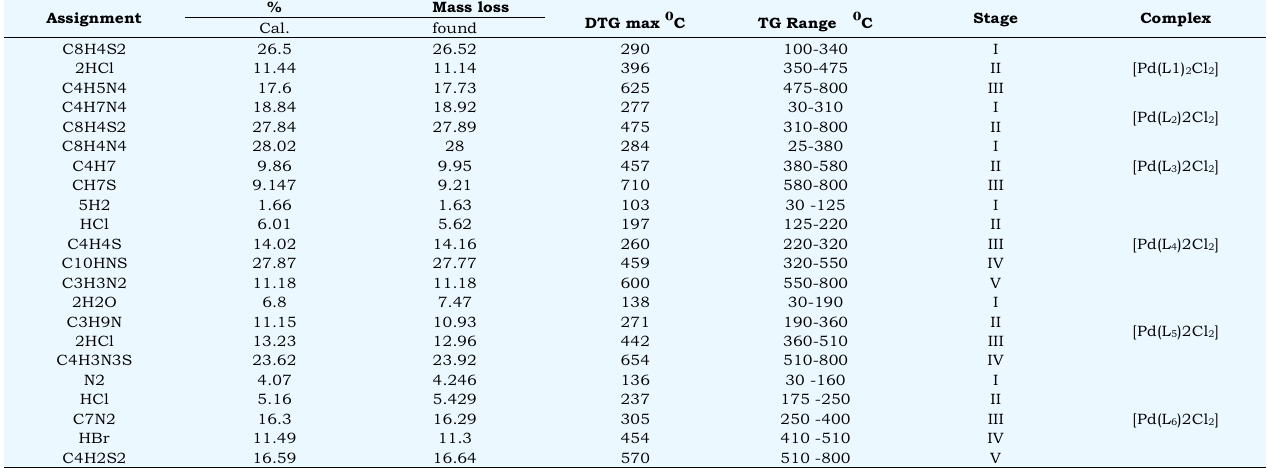
Table 3 Thermo analytical results (TG, DTG) of palladium complexes with with 2-Amino 4-(4-substitutedphenyl) thiazole derivatives